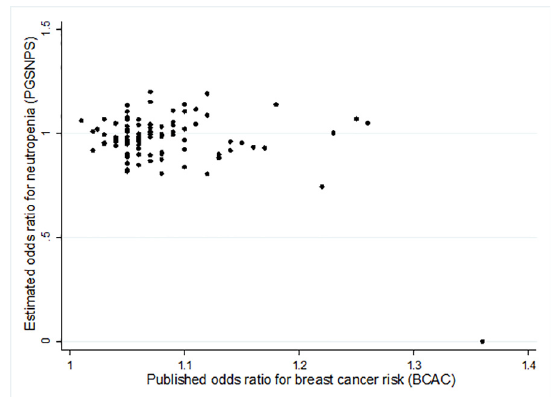
Fig 2. Scatter plot comparing variant-associated odds ratios for breast cancer risk, published by the Breast Cancer Association Consortium (BCAC), with odds ratios for neutropenia risk estimated in the Pharmacogenetic SNPs (PGSNPS)